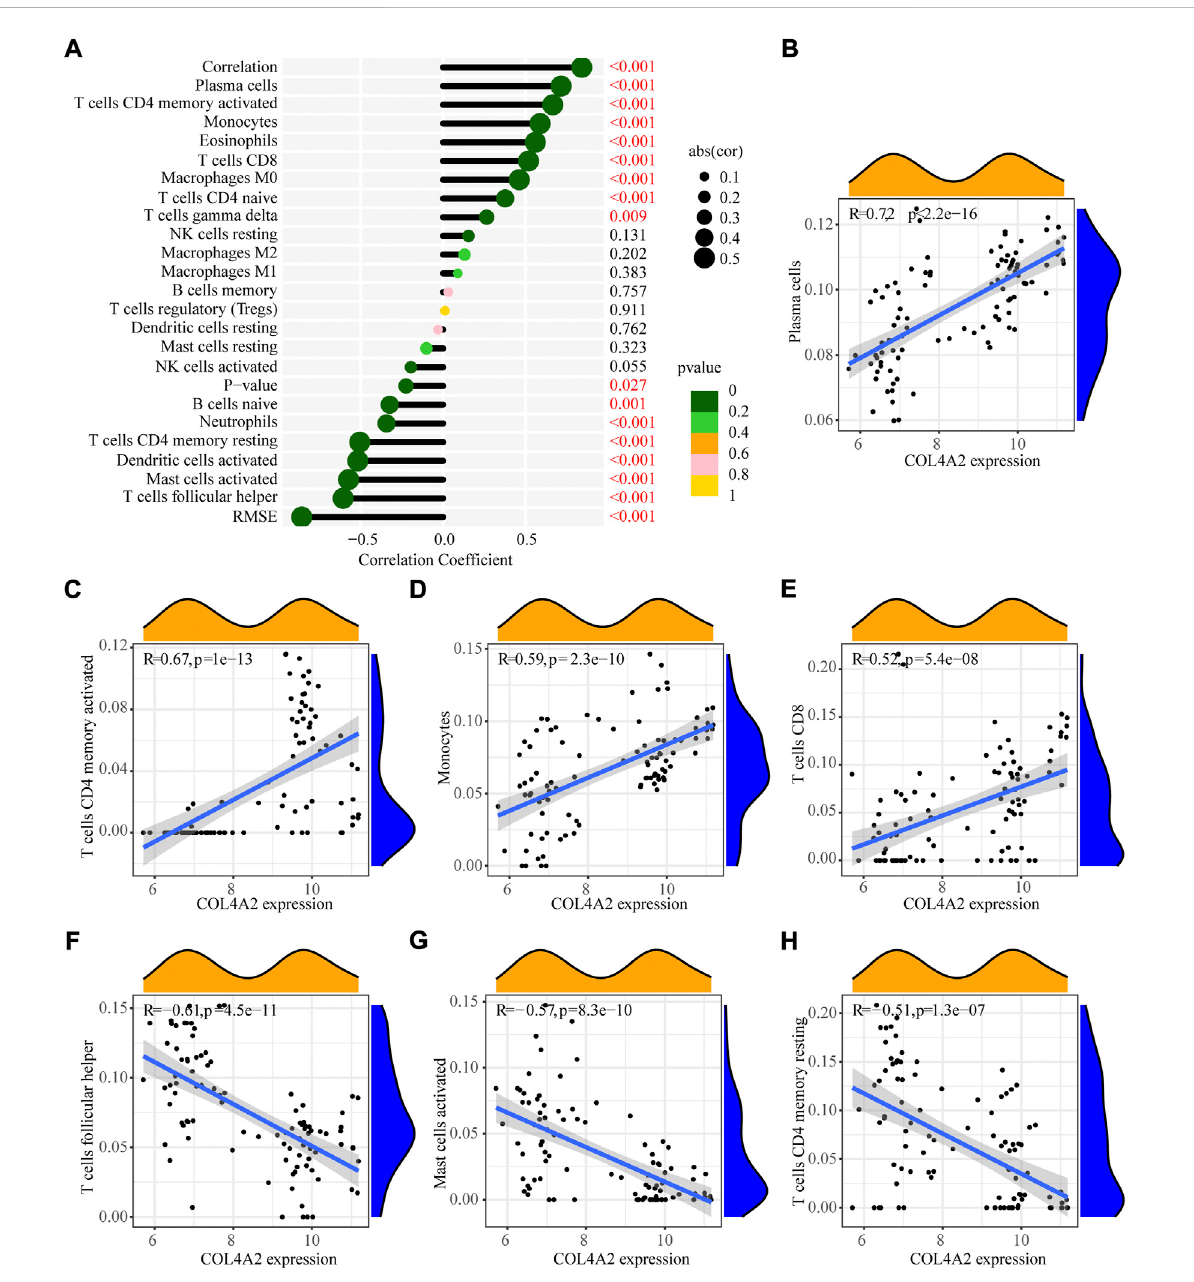
FIGURE 7 Pearson correlation of immune in fi ltrating cells with the signature genes. (A) Correlation between COL4A2 and in fi ltrating immune cells. (B) Plasma cells. (C) Activated CD4 memory T cells. (D) Monocytes. (E) CD8 T cells. (F) Follicular T helper cells. (G) Activated Mast cells. (H) Resting CD4 memory T